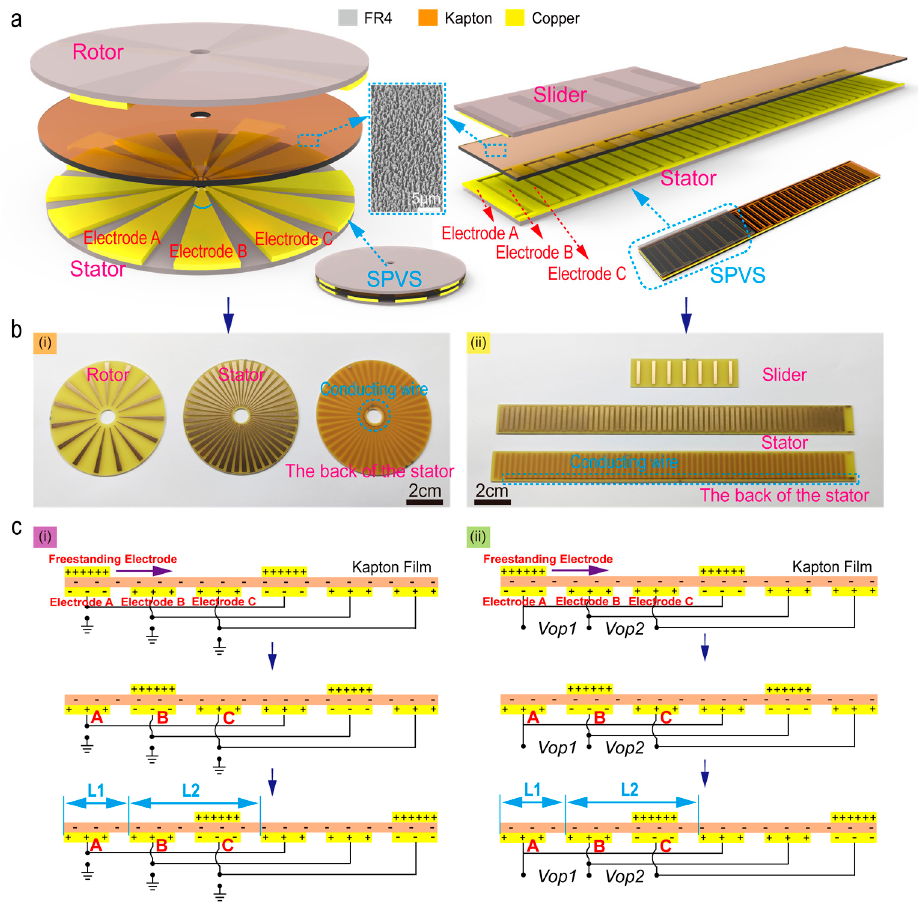
Figure 1. Structural design and working mechanism of the self-powered vector angle/displacement sensor (SPVS). ( a ) Schematic illustrations of disc-shaped ( left ) and strip-shaped ( right ) SPVS as well as the corresponding enlarged view of rotor/slider and stator. Inset: a scanning electron microscopy (SEM) image of the etched nanorods on the surface of Kapton film (the scale bar: 5 µ m). ( b ) Optical photos of disc-shaped and strip-shaped SPVS, where a set of interdigital electrodes are connected together by conducting wires on their bottom stator. ( c ) Schematic operating principle of SPVS with two different detect modes.